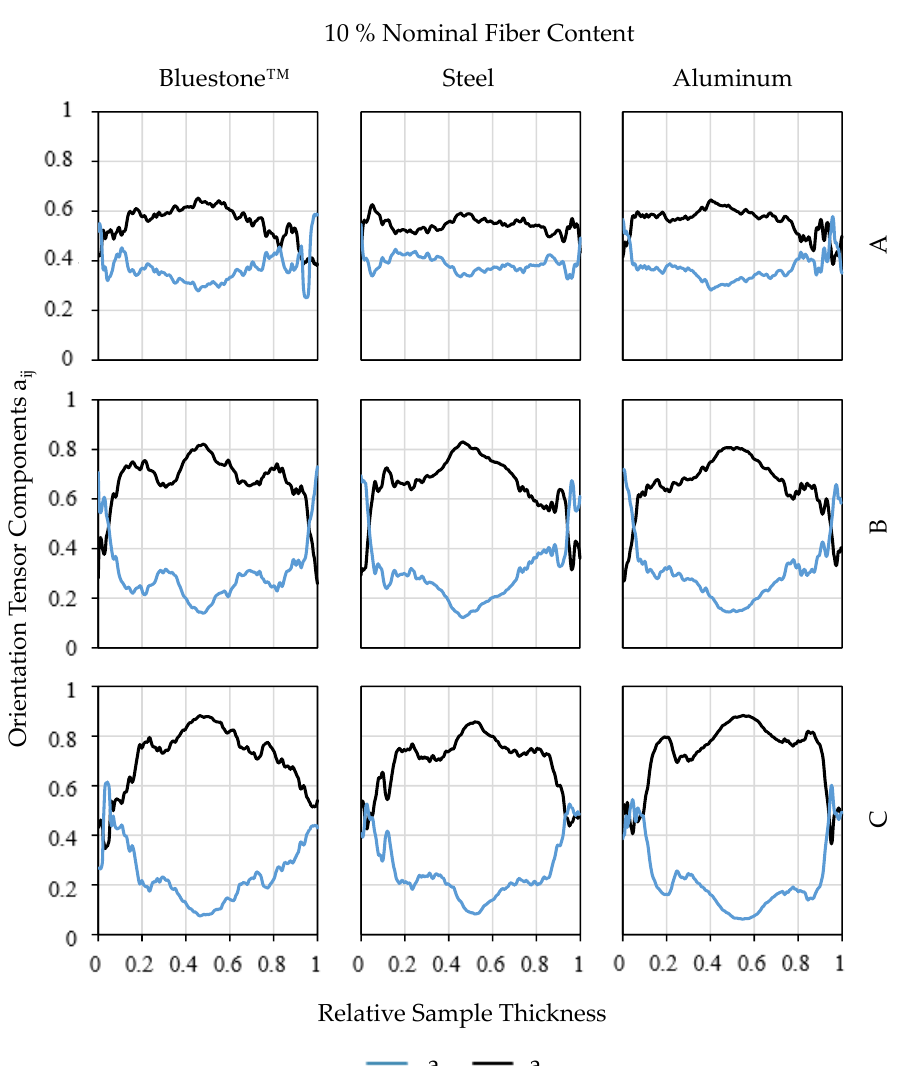
Figure A1. Orientation tensor components ( a 11 , a 22 ; without a 33 for better overview) and relative sample thickness for a nominal fiber content of 10 wt.%. Specimens were created with Bluestone, steel, and aluminum tools, with samples from regions A, B, and C (in accordance with Figure 9).